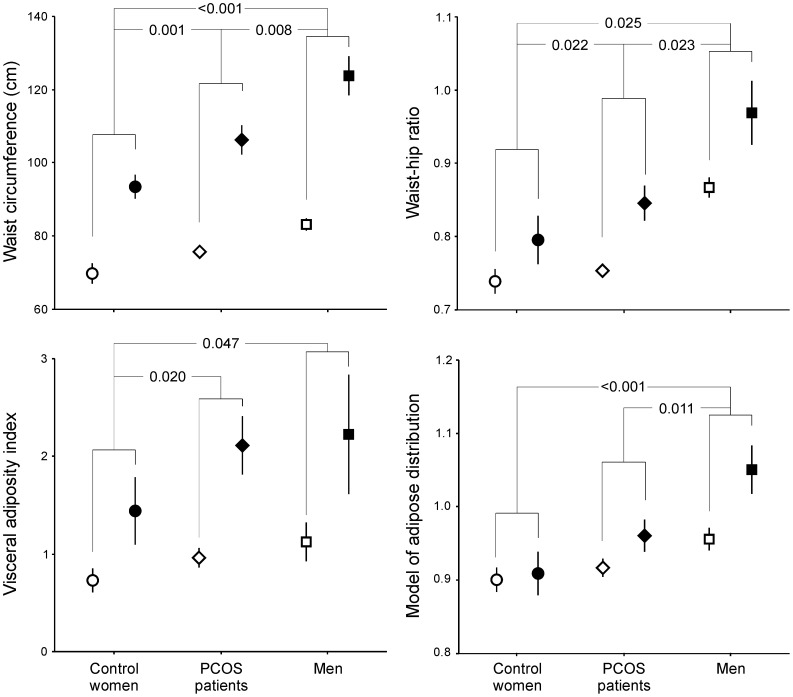
Surrogate indexes of visceral adiposity in control women (circles, n = 20), women with polycystic ovary syndrome (PCOS, diamonds, n = 53) and men (squares, n = 26) as a function of obesity (defined as BMI ≧30 kg/m2, white symbols  =  non-obese subjects, black symbols  =  obese individuals).Data are means ± SEM and were submitted to univariate general linear models introducing groups of subjects and obesity as independent variables and age as a covariate to correct the results for a difference in age among patients with PCOS with the other groups. Obese subjects showed increased total body fat mass values when compared with non-obese individuals (P<0.001 for all indexes with the exception of MOAD, P = 0.011), irrespective of sex and PCOS. P values indicate the differences between control women, women with PCOS and men, irrespective of the presence or absence of obesity. No interaction was found between obesity and groups of subjects in any of the measurements of the indexes of visceral adiposity.